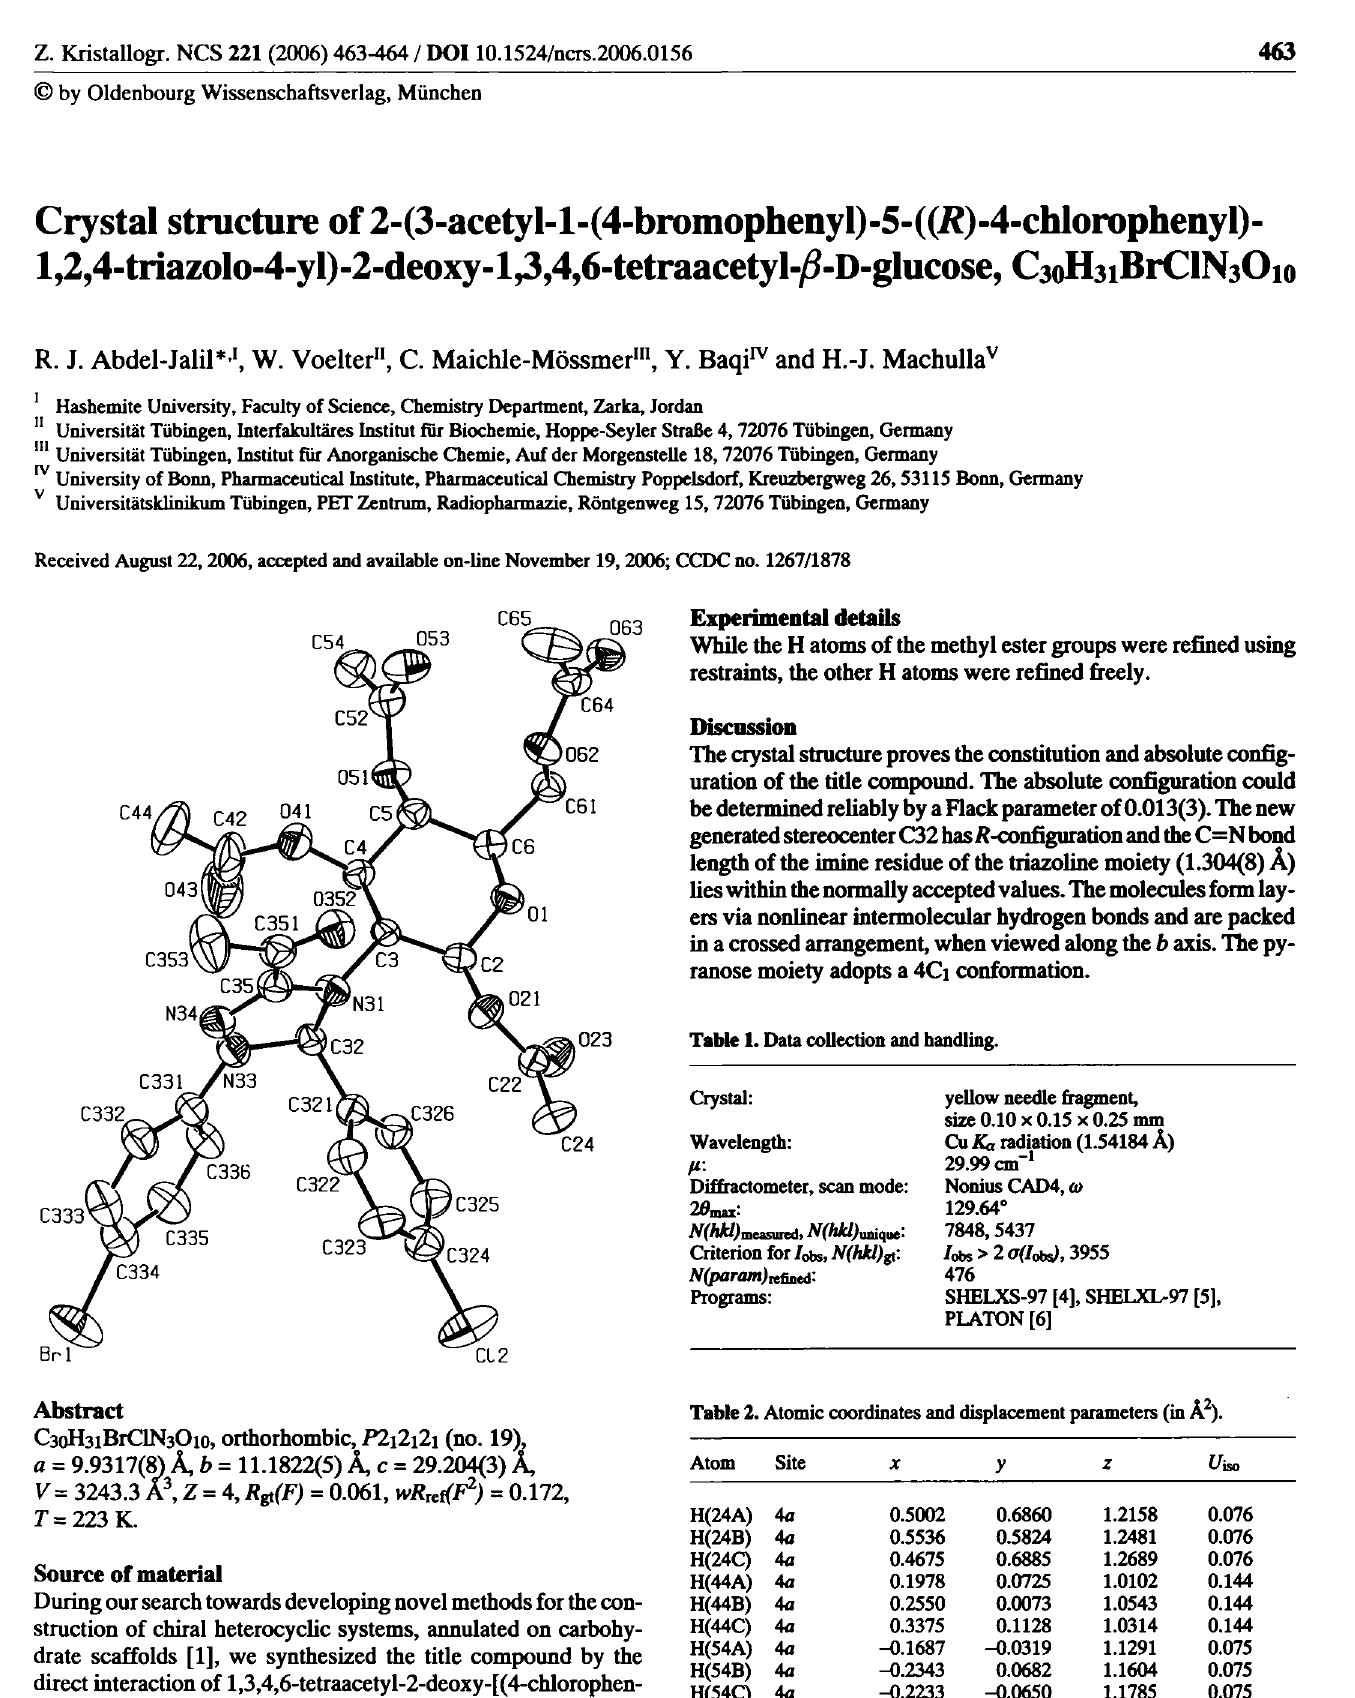
Table 2. Atomic coordinates and displacement parameters (in A 2